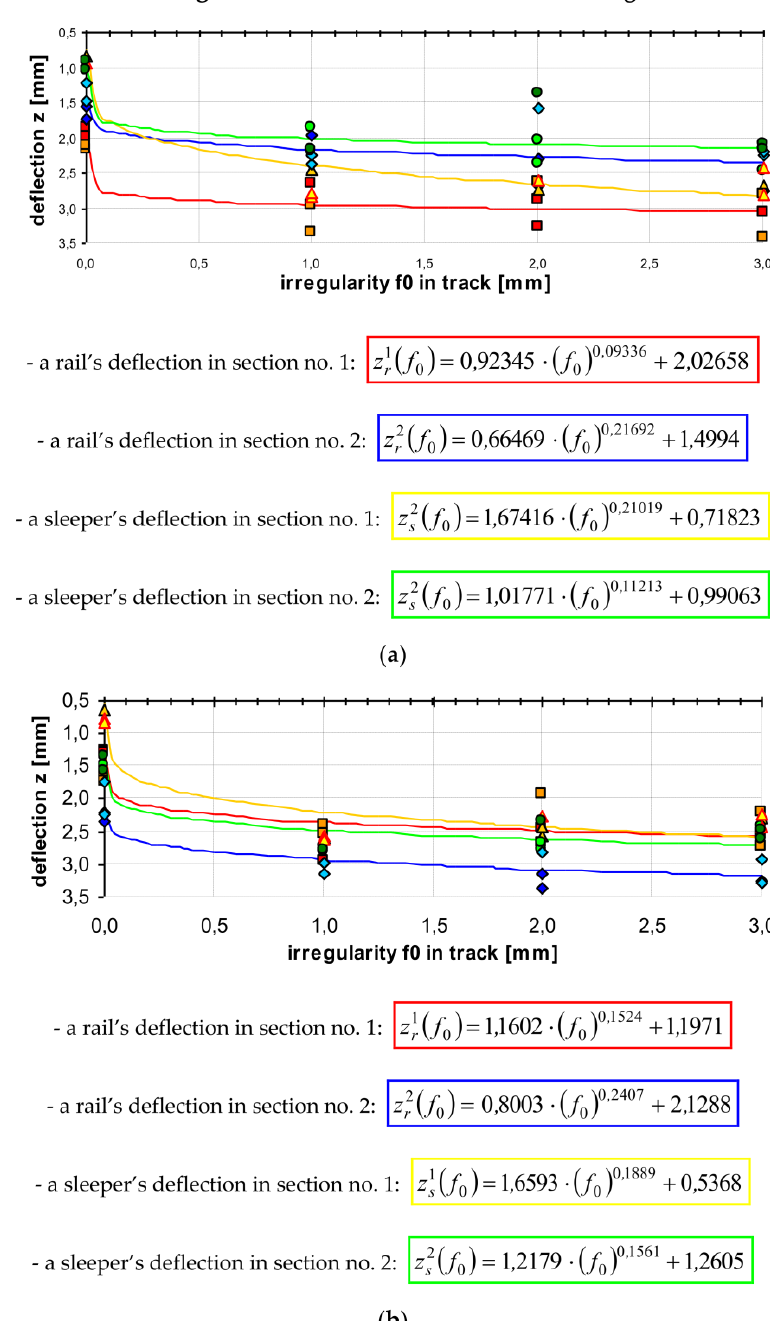
11 of 30 Figure 6. Decreasing of cross-section no. 2 — loads from the succeeding axles on cross-section no. 2 (a scheme from Figure 3) (Pontos viewer). A deflection of the rail and the sleeper due to induced irregularity in the railway track during a de- flection of the cross-section no. 2; ordinate axis-a deflection of rail and sleeper; abscissa axis-consecutive measurements every 0.005 [s]; one step of stage = 0.005 [s]: ( a ) with an irregularity f 0 = 0 mm in track; ( b ) with an irregularity f 0 = 1 mm in track; ( c ) with an irregularity f 0 = 2 mm in track; ( d ) with an irregularity f 0 = 3 mm in track. 5. Results and Discussion of Obtained Effects 5.1. The Results of Deflections of the Rail and the Railway Sleeper Obtained during Field Investigations In the place of the intentionally generated railway track irregularity, for the suc- ceeding four axles of the SM-42 locomotive the following measurements were, among others, done for sections no. 1 and no. 2: •